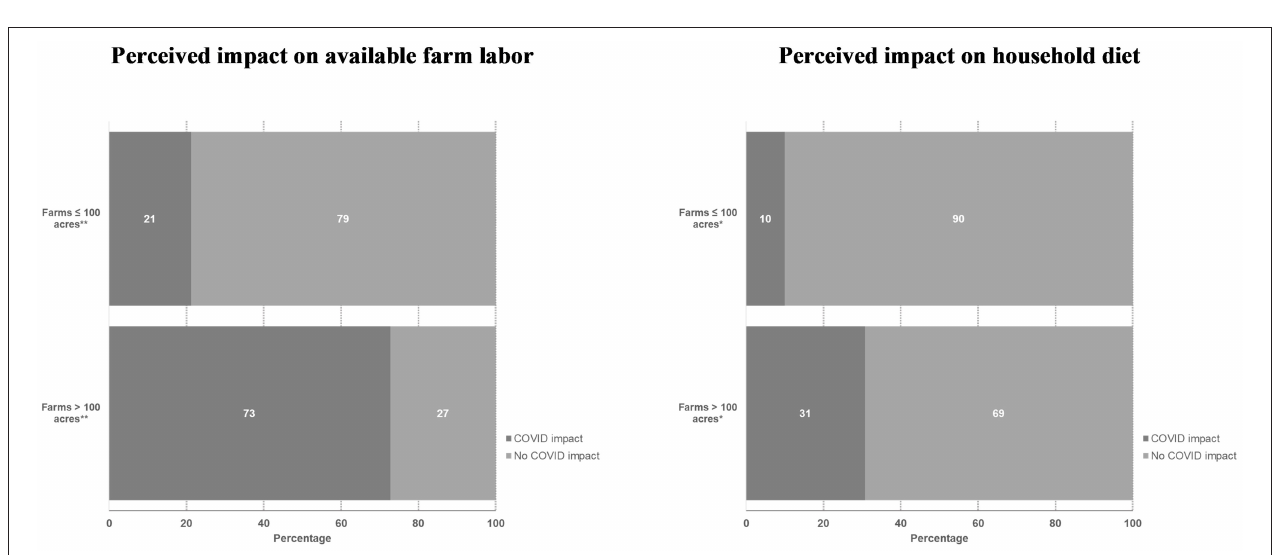
FIGURE 4 | Impact of farm size on perceived available farm labor and household diet (% of all responses, n = 42, NR = 9). *Moderate relationship [Cramer’s V > 0.2 ∧ p (Chi-Square) < 0.1]. **Strong relationship (V > 0.3 ∧ p <